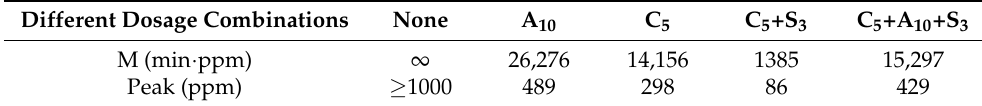
Figure 5. Asphalt VOCs emission curves under different modifier combinations. Table 3. Asphalt VOCs emissions M and peak P under different modifier combinations.